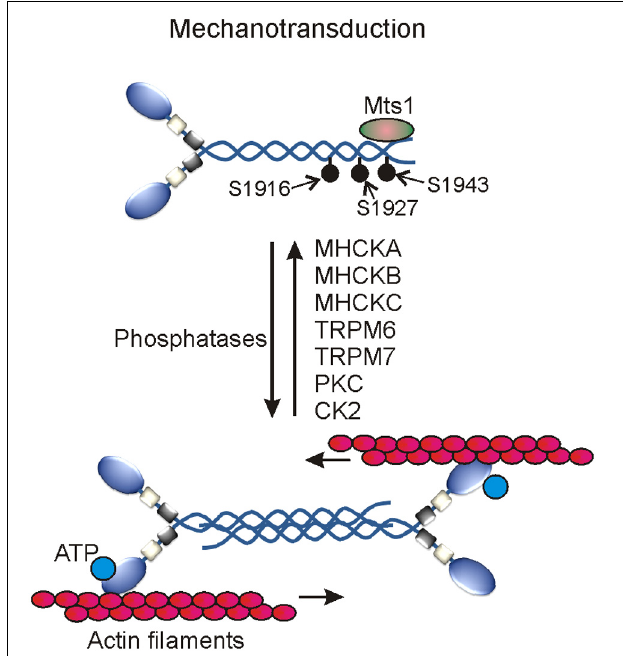
FIGURE 3 | Myosin II motor proteins-mediated mechanotransduction in cells. Several myosin II heavy chain specific protein kinases activate myosin II motor proteins. The activated myosin II associates with actin filaments to generate contractile forces using cellular